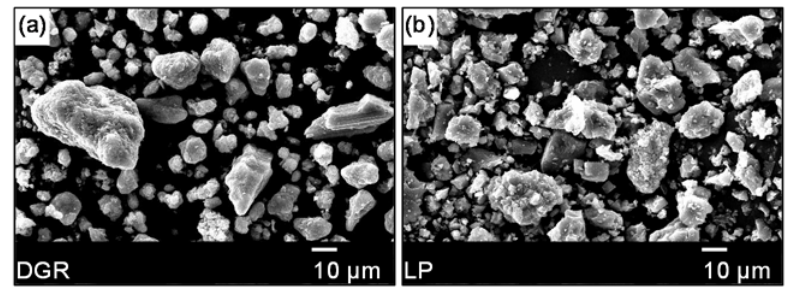
10 of 19 Figure 8. Mineral phases of DGR. The average chemical compositions of LP and DGR corresponded to the mineral phase results. The decomposition of CaCO 3 in LP resulted in large amounts of CaO and loss on ignition (LoI). The mass ratio of CaO to LoI was 1.28, which was very close to the molecular weight ratio of CaO to CO 2 . It proved that the release of CO 2 should be responsible for the large LoI in LP. For DGR, the contents of CaO, SO 3 and LoI were much larger than that of other chemical compositions. The CaO was related to CaCO 3 , Ca(OH) 2 , CaSO 3 ·0.5H 2 O and CaSO 4 ·2H 2 O phase. Supposing the large LoI was completely caused by the decomposition of CaCO 3 (in fact, the dehydration process of mineral phases also made contribution to it), the amount of CaO generated during the release of CO 2 was 18.98%. The content of CaO corresponding to CaSO 3 ·0.5H 2 O and CaSO 4 ·2H 2 O was 14.15%, computed according to the total content of SO 3 shown in Table 5. The total content of CaO for DGR was 59.88%, therefore, there were about 26.75% of CaO was from Ca(OH) 2 . It also indicated that the amount of retaining Ca(OH) 2 was large, which contributed to the alkaline of DGR. Table 5. Average chemical compositions of DGR and LP. Filler